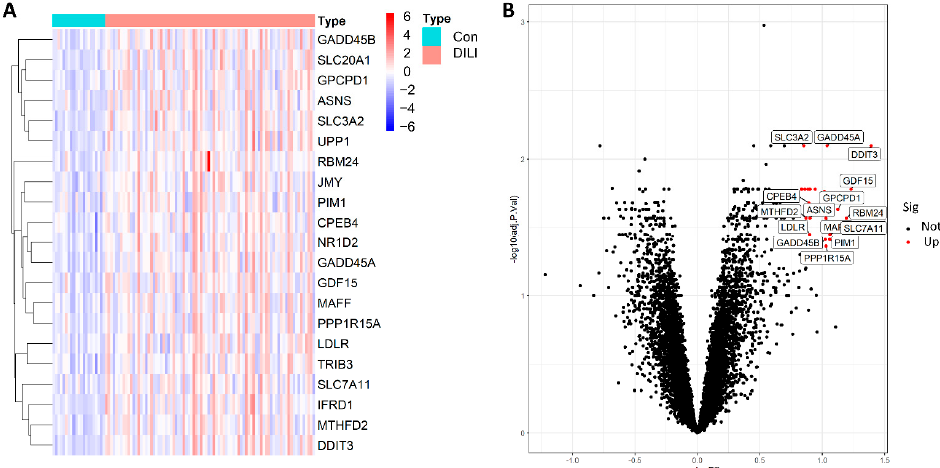
Figure 2. The 21 DEGs were distributed in both the DILI group and the control group (|log FC| > 0.8, FDR < 0.05, and p -value < 0.05). ( A ): heatmap of 21 DEGs between the Con and DILI groups; ( B ), volcano diagram of all genes; red represents significantly upregulated genes in the DILI group compared to Con group, and black represents not significantly upregulated genes. R software (version 4.1.4; written by Ross Ihaka and Robert Gentleman from the University of Auckland originally, N.z., and maintained by Lucent Technologies, USA, https://www.r-project.org/) was used to create the maps, including R package pheatmap (version 1.0.12; created by Raivo Kolde’ team; https://cran.r-project.org/web/packages/pheatmap/index.html) for the heatmap and ggplot2 (ver- sion 3.35; written by Hadley Wickham; RStudio, USA, https://cran.r-project.org/web/pack- ages/ggplot2/index.html) for the volcano plot, respectively. FC, fold change; FDR, false-discovery rate.